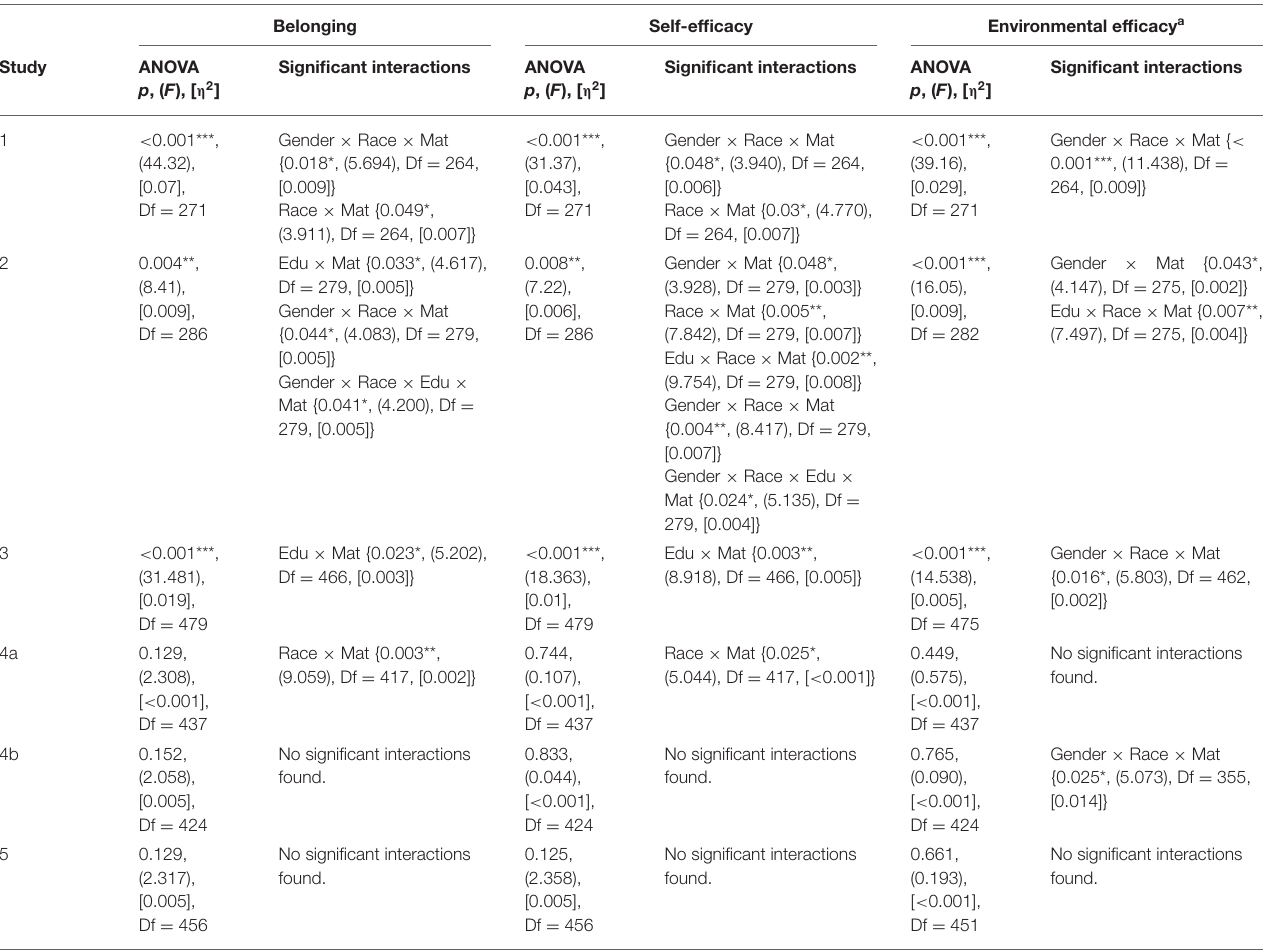
TABLE 4 | ANOVA and mixed ANOVA results for materials for all three dependent variables. Belonging Self-efficacy Environmental efficacy a Study ANOVA Significant interactions ANOVA Significant interactions ANOVA Significant interactions p , ( F ), [ η 2 ] p , ( F ), [ η 2 ] p , ( F ), [ η 2 ]